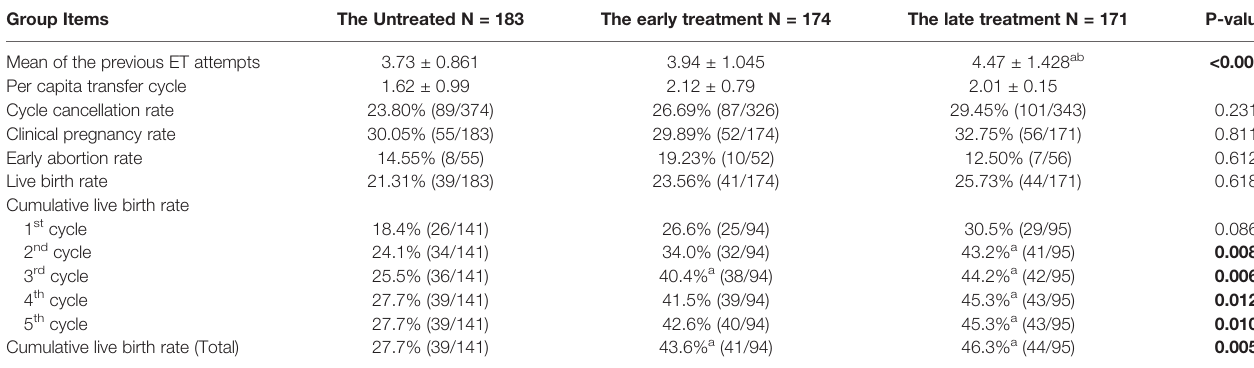
TABLE 1 | Clinical pregnancy outcomes of embryo transfer cycles of endometriosis patients with